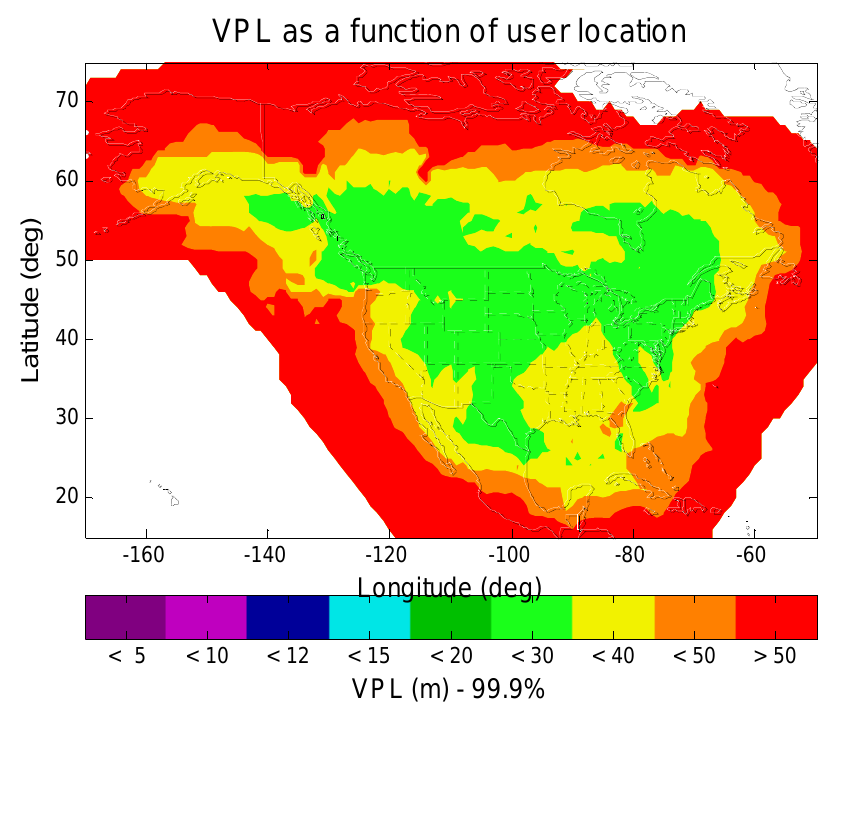
Figure 3. The 99.9% VPL contour of the upgraded WAAS. The VPL values in all of CONUS and in most of Alaska are less than 50 m (LPV